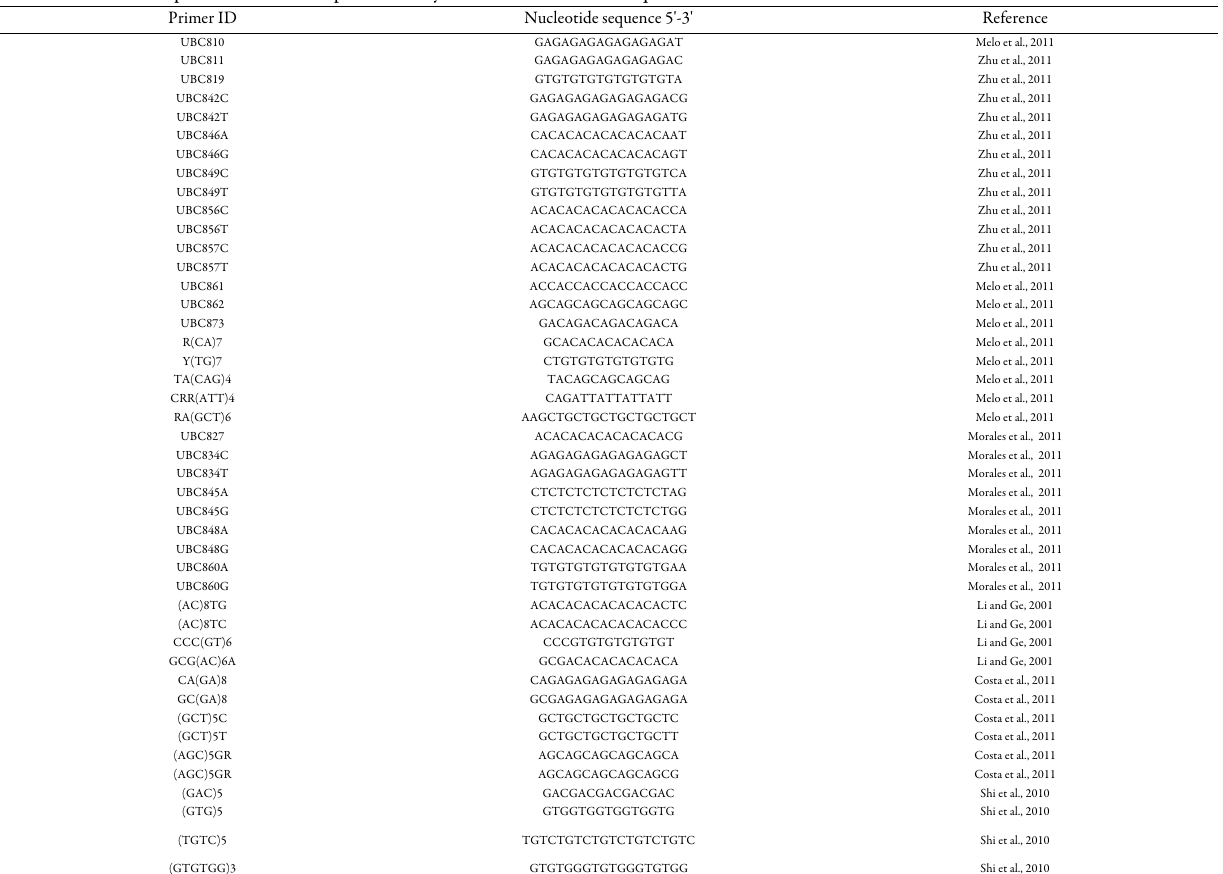
Table 7. List of ISSR primers used in the present study with their nucleotide sequence and references Primer